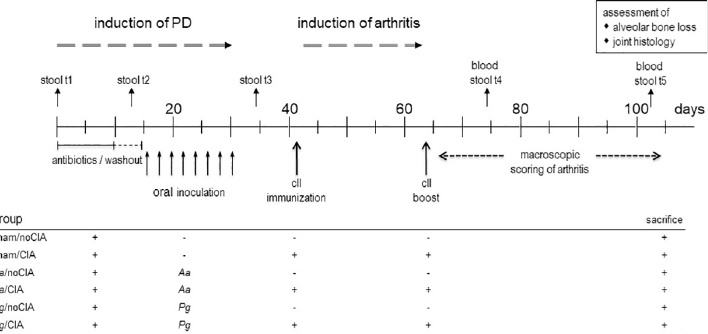
Fig 1. The experimental setup of periodontal disease induced before CIA. Periods for antibiotics treatment and macroscopic scoring of arthritis are indicated by horizontal lines and arrows, while individual days for oral application of the pathobionts, immunization, boost as well as blood and stool sampling are shown by vertical arrows. Experimental endpoint was day 105 and assessments of alveolar bone loss and joint histology were only made thereafter. Tables below the graphs summarize the individual experimental groups. Pg : Porphyromonas gingivalis ; Aa : Aggregatibacter actinomycetemcomitans ; sham: oral inoculation with PBS/ sodium carboxymethylcellulose.